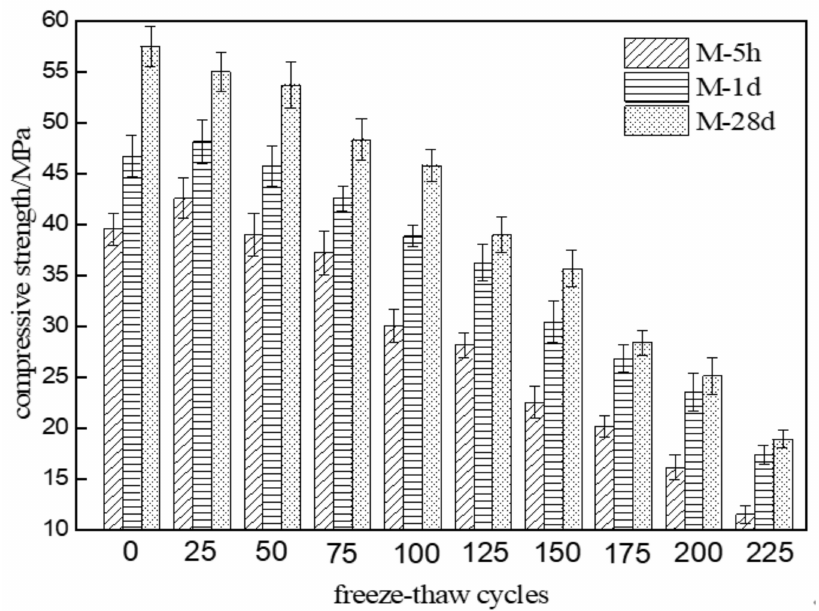
Figure 3. Compressive strength changes of MKPC mortar specimens with the number of freeze–thaw cycles in